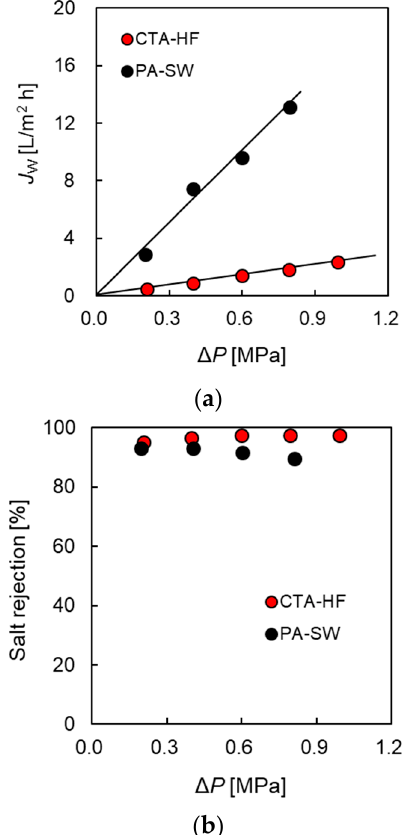
Figure 3. ( a ) Water flux and ( b ) salt rejection as a function of applied pressure in RO mode. Q FS : 4.0 L/min. Tap water and 500 ppm NaCl were used as feed solution in the measurement of water flux and salt rejection,